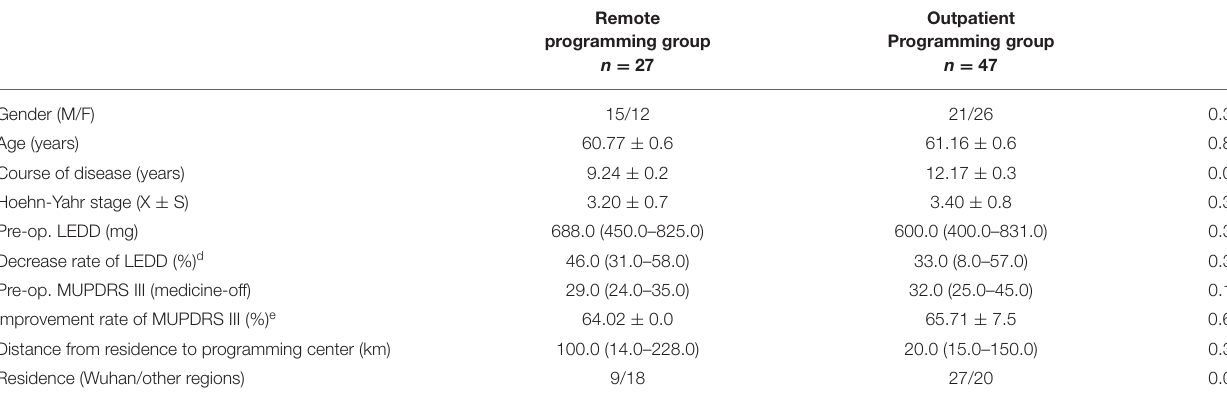
TABLE 1 | Clinical data between remote and outpatient programming